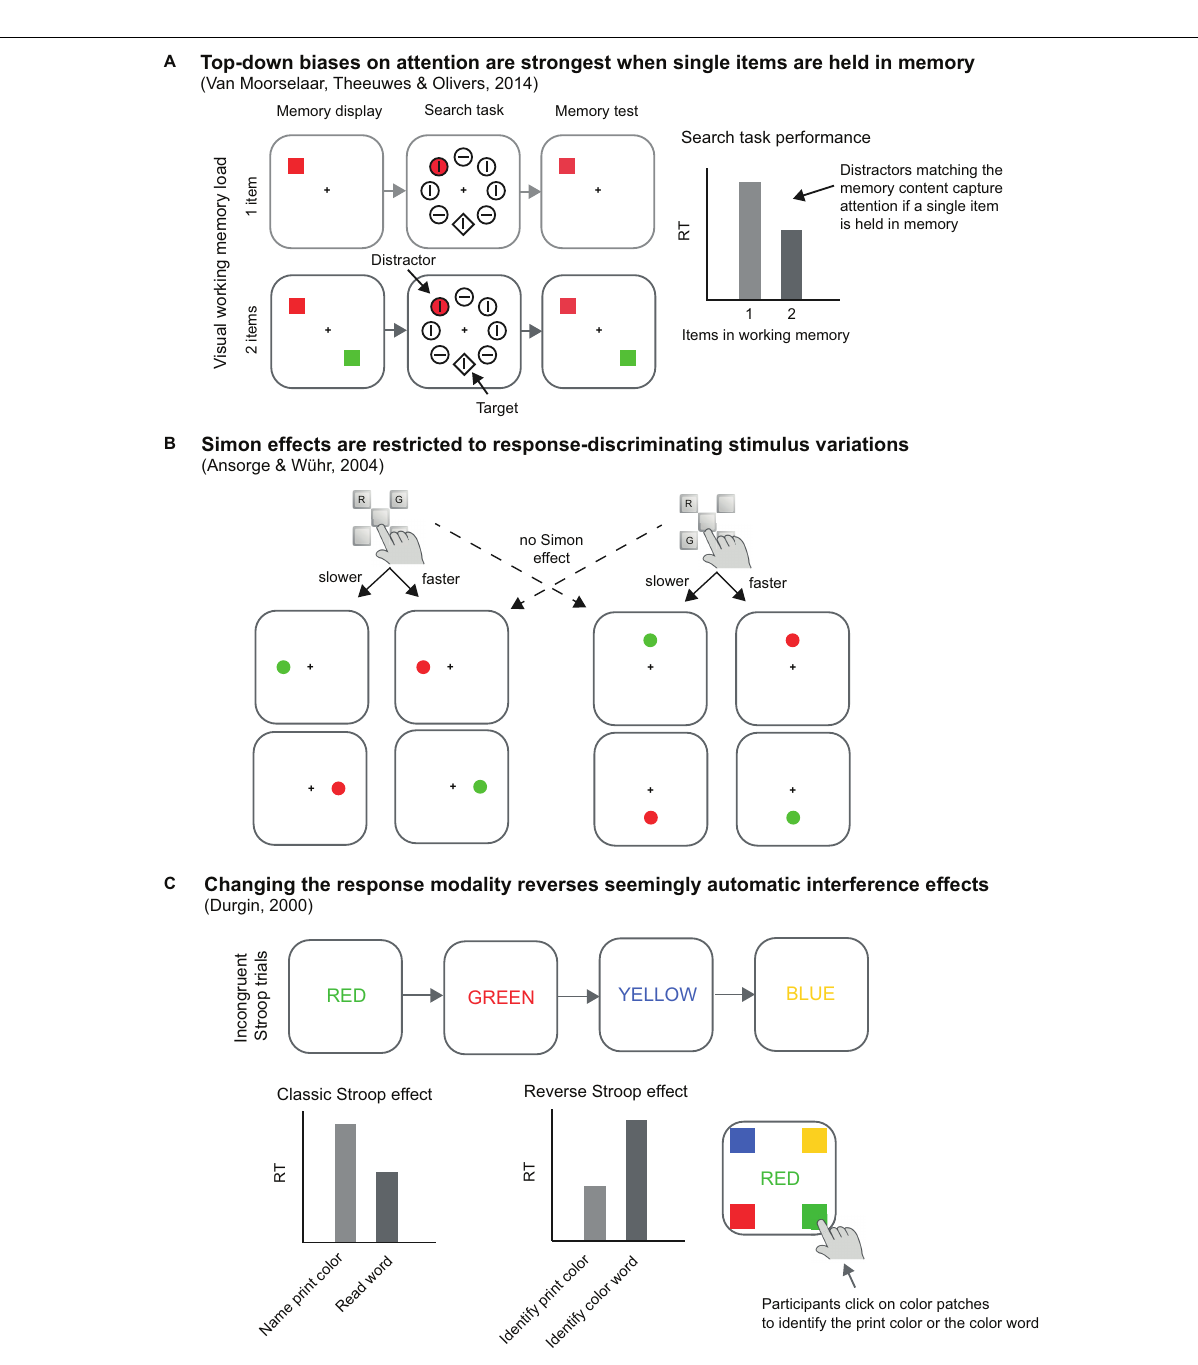
Participants click on color patches to identify the print color or the color word